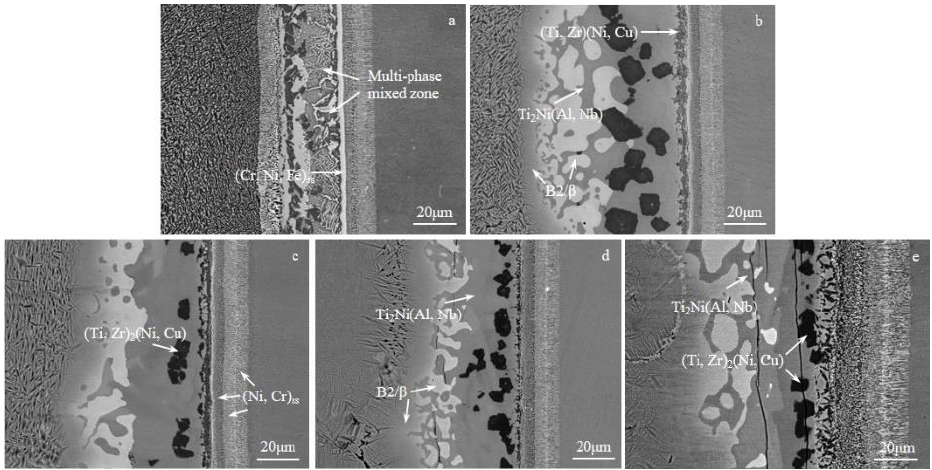
Figure 6. Microstructures of Ti 2 AlNb/GH99 joints brazed at different temperatures for 10 min. ( a ) 960 °C; ( b ) 980 °C; ( c ) 1000 °C; ( d ) 1020 °C; ( e ) 1040 °C.